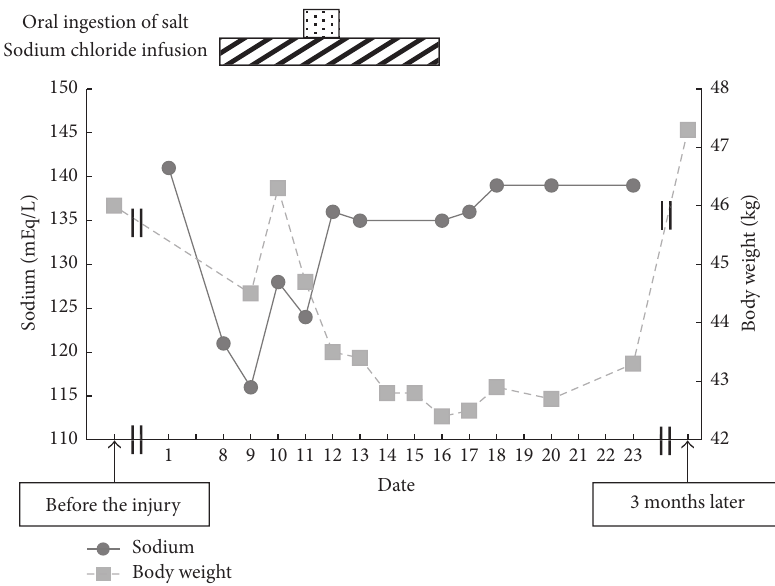
Figure 1: Clinical course of treatment and